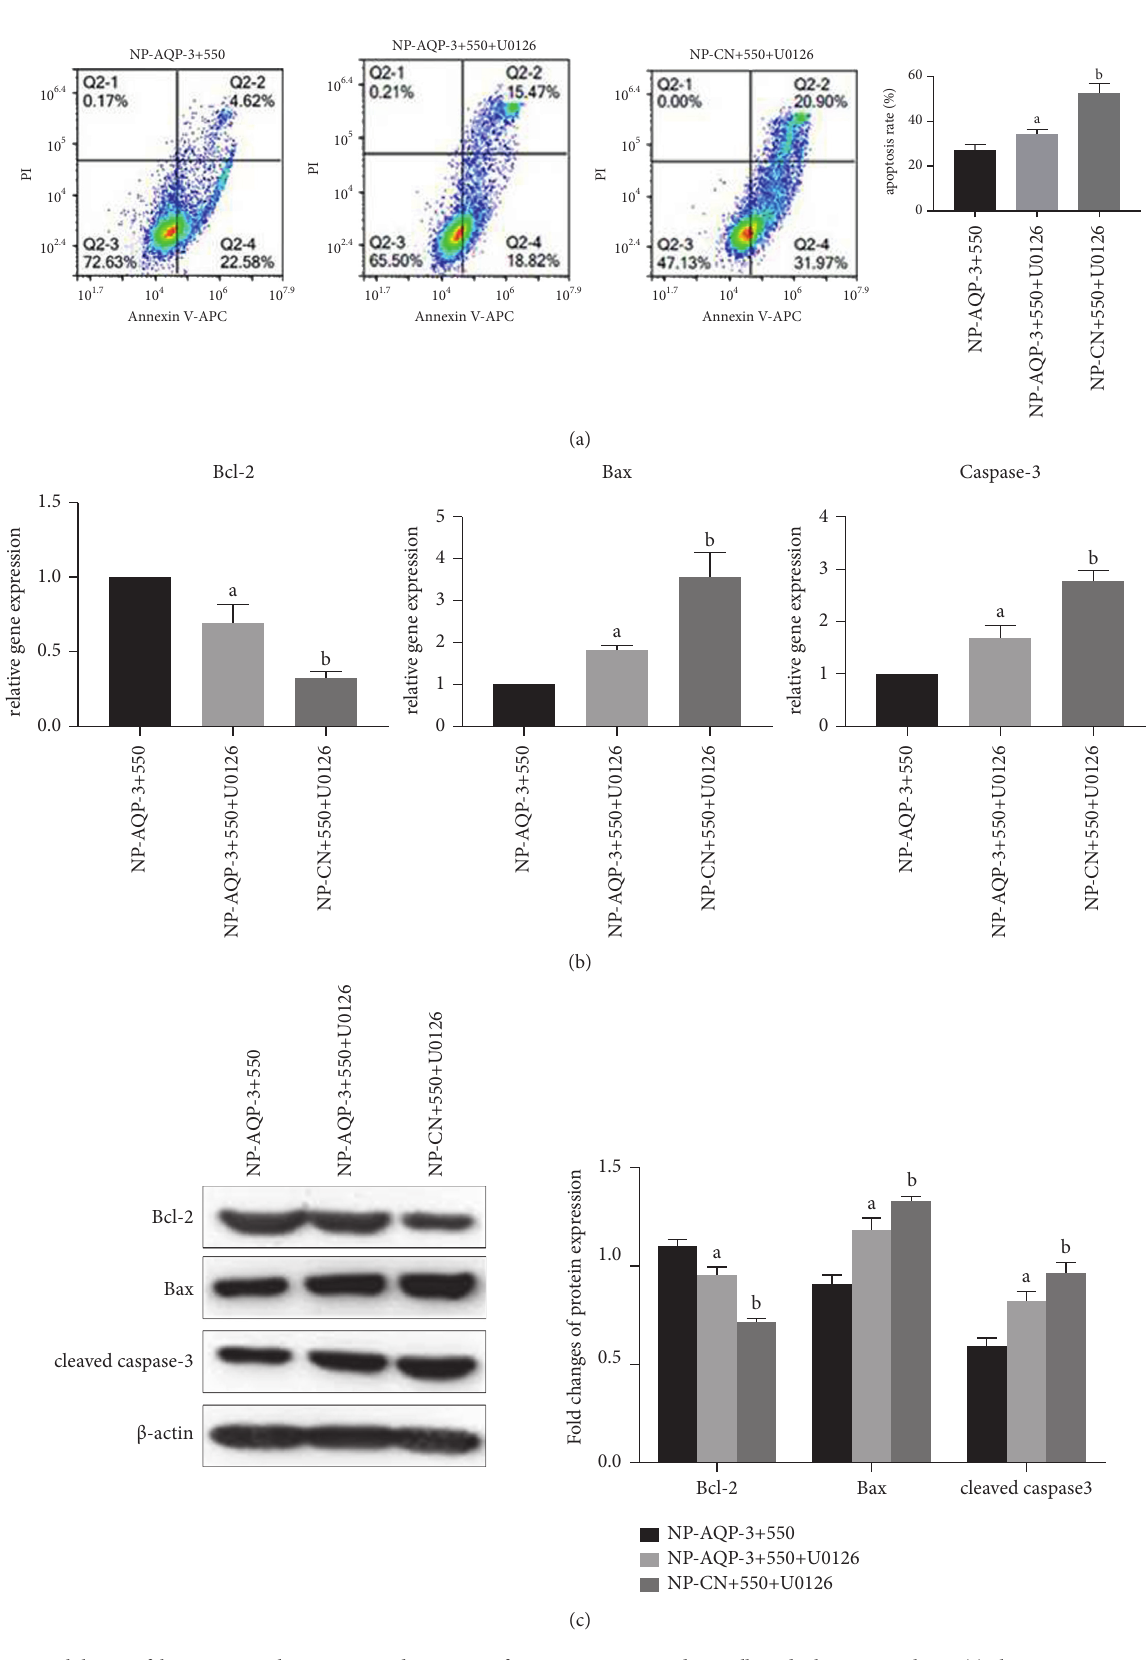
Figure 6: InhibitionoftheERK1/2pathwaypromotedapoptosisofAQP-3overexpressedNPcellsunderhyper-osmolarity.(a)Flowcytometryanalysisof cell apoptosis rate under hyperosmolarity. (b) and (c): real-time PCR and western blotting analysis of proapoptosis (Bax and caspase-3/cleaved caspase-3) and antiapoptosis (Bcl-2) molecules under a hyperosmolarity, respectively. NP-AQP-3+550: AQP3 overexpressed NP cells cultured in 550mOsm/kg; NP-AQP-3+550+U0126: AQP3 overexpressed NP cells cultured in 550mOsm/kg medium containing U0126; NP-CN+550+U0126: NP cells without transfection (NP-CN) cultured in 550mOsm/kg medium containing U0126. (A) indicates a significant difference ( p < 0 . 05) when compared with the group of NP-AQP-3+550. (B) indicates a significant difference ( p < 0 . 05) when compared with the group of